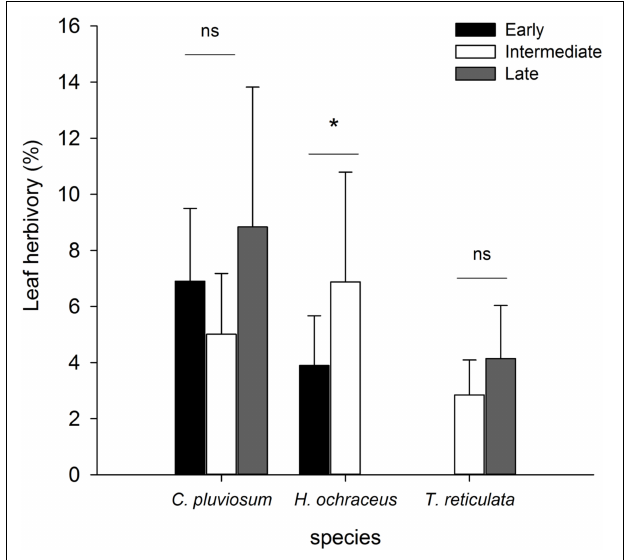
FIGURE 3 | Mean ( ± standard deviation) percentage of leaf damage for three plant species at different successional stages in a tropical dry forest. The asterisk indicates differences on mean herbivory at the intraspecific level among successional stages ( P < 0.05). ns = P >